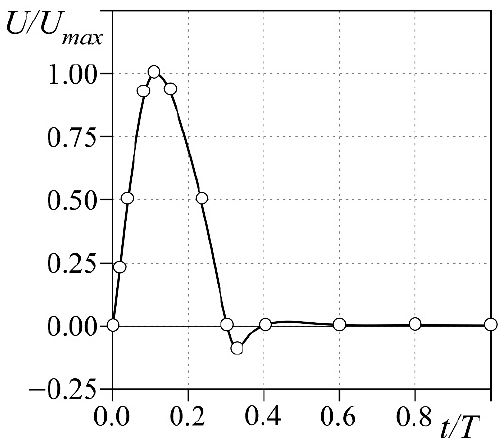
Figure 3. Flow condition prescribed at the inlet of the CFD